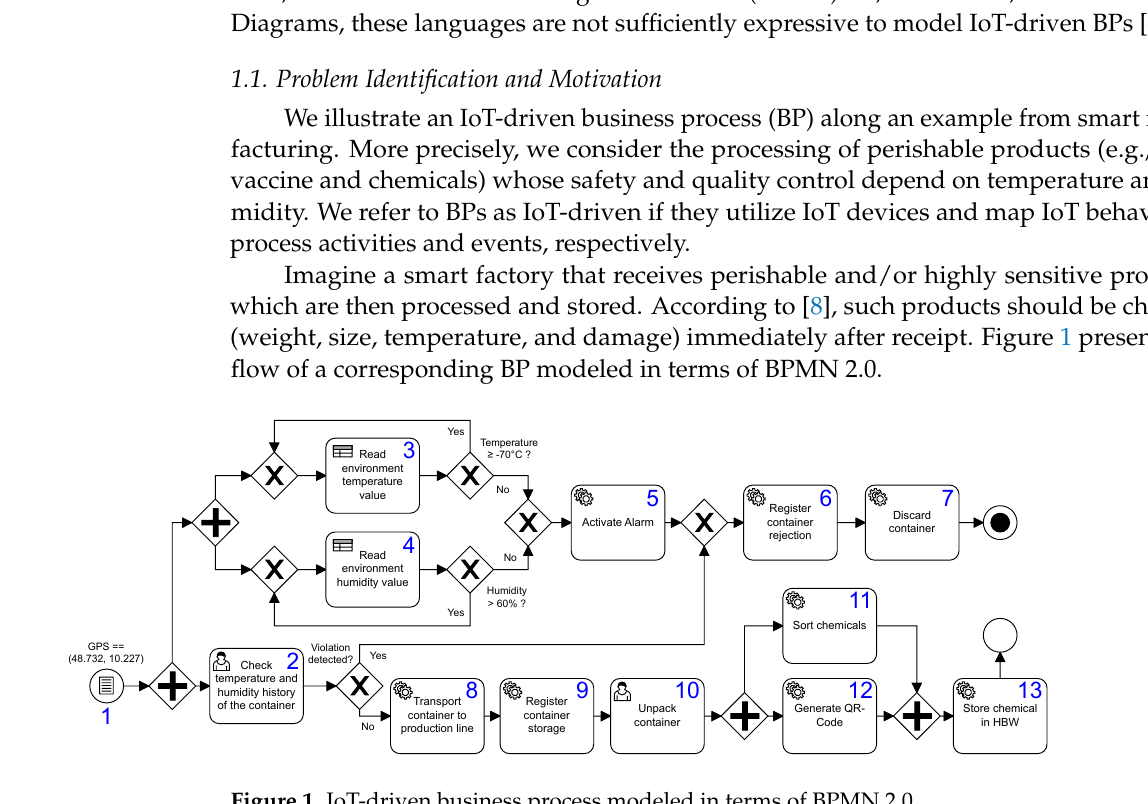
Figure 1. IoT-driven business process modeled in terms of BPMN